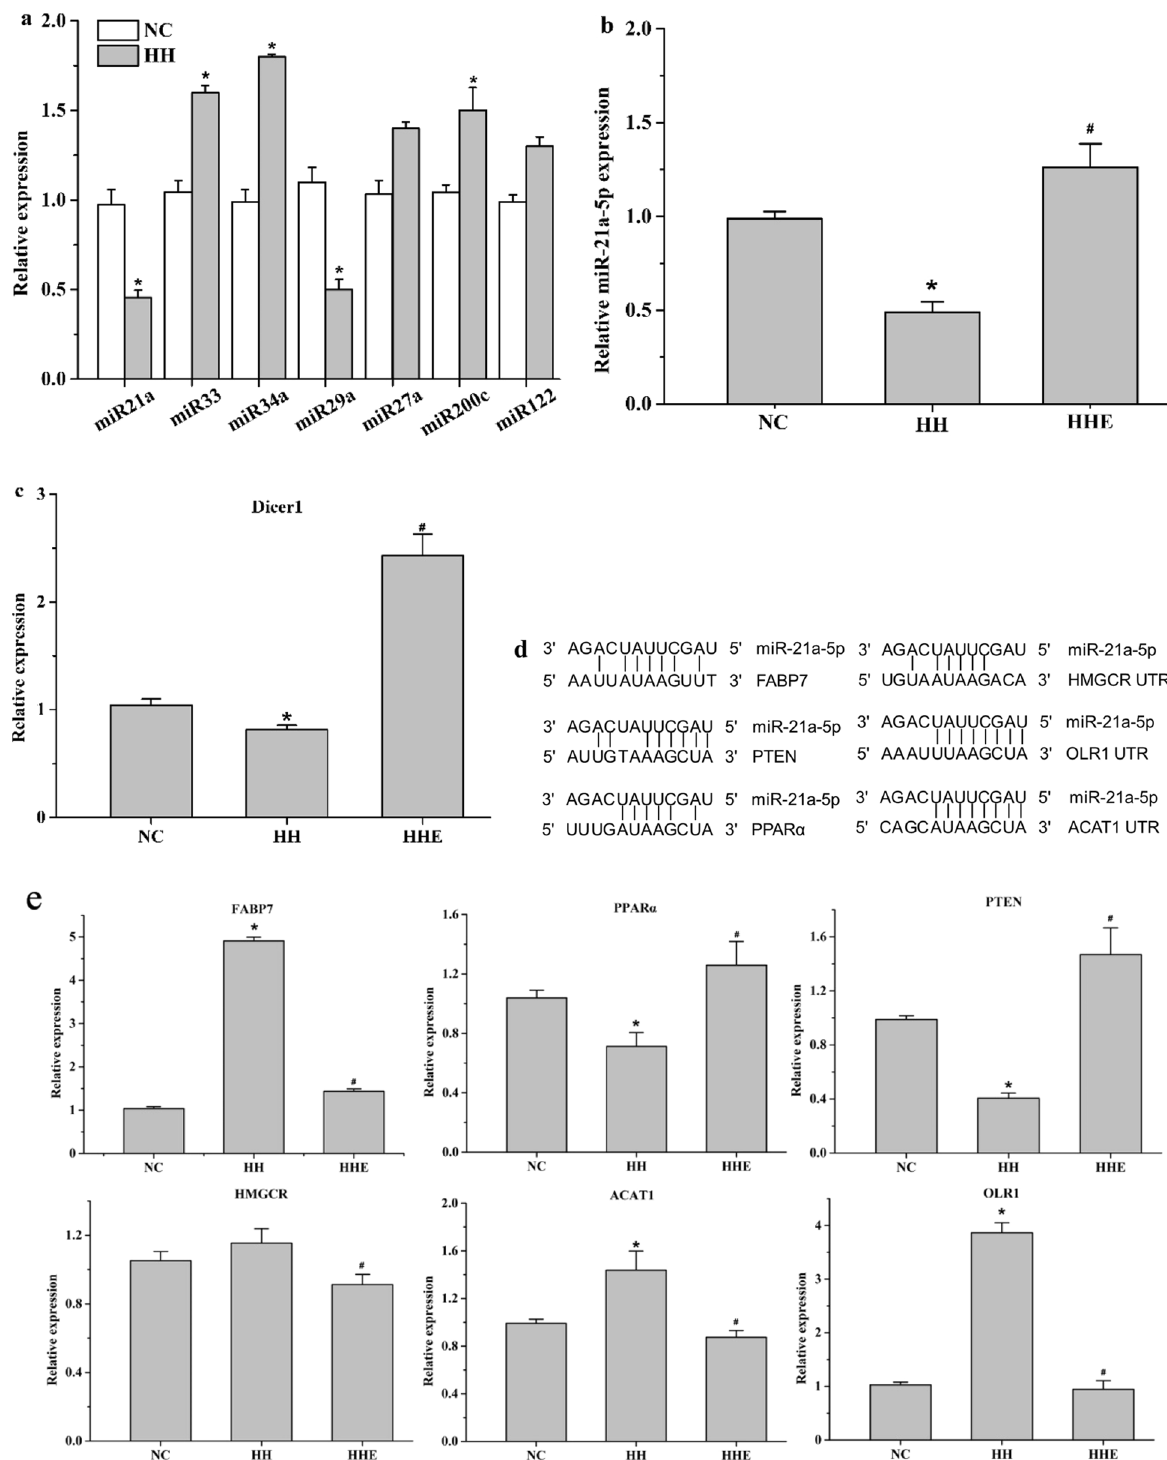
Figure 3. Effects of aerobic exercise on the expression of miR-21a-5p and its target genes. ( a ) Relative levels of miRNAs in the liver of mice fed a high-fat diet. ( b ) qPCR was used to detect the expression of miR-21a-5p in NC, HH, and HHE groups. ( c ) The mRNA levels of Dicer1. ( d ) Schematic diagram of miR-21a-5p seed sequence with the 3 ′ -UTR binding site of target genes. ( e ) The mRNA levels of miR-21a-5p targets were detected by QPCR. ( f ) The protein levels of miR-21a-5p targets were determined by western blot, original western blot gel figures are presented in Supplementary data. *P < 0.05 VS NC group, # P < 0.05 VS HH